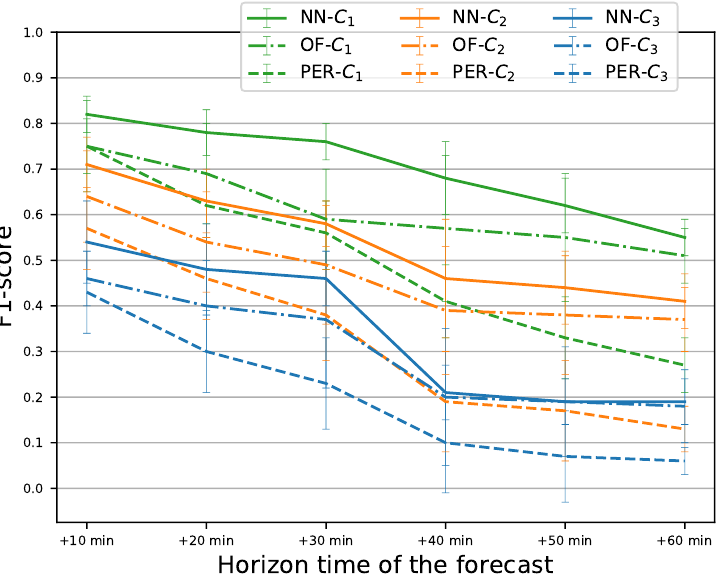
Figure 12. Evolution of models’ performance (in sense of F1 -score) according to the horizon forecast, from 10 min up to 1